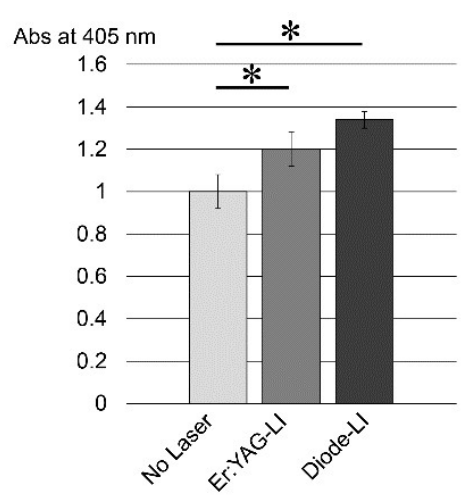
Figure 4. Effect of LI on ALP activity in PPU-7. ALP-inducing activity in PPU-7 after 3 days of exposure to a Er:YAG laser (Er:YAG-LI) or a diode laser (Diode-LI) ( n = 6). No Laser: control without LI. Values are the mean ± standard error (* p < 0.01, Steel’s test).